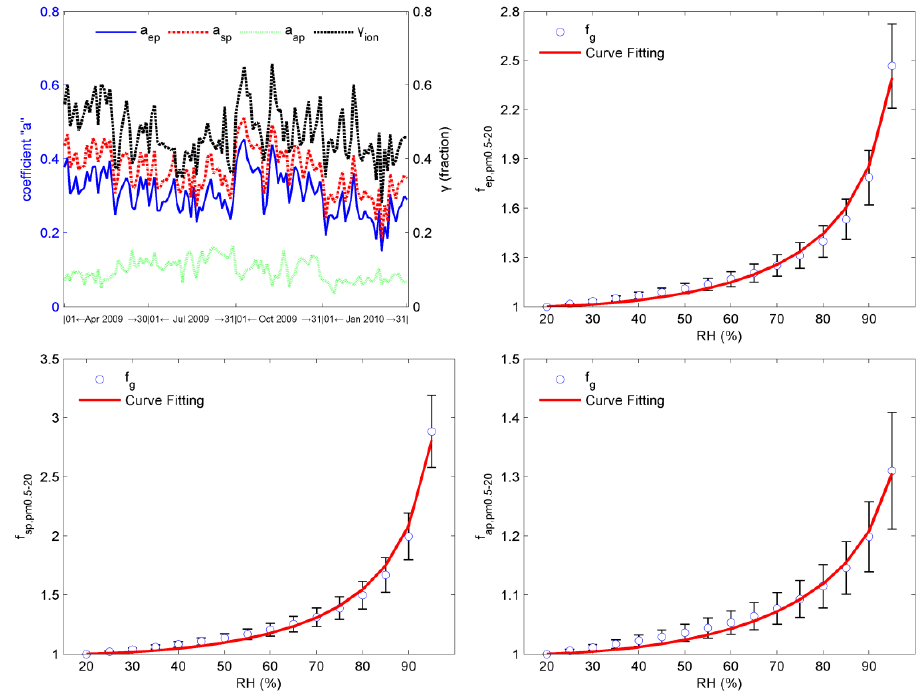
Figure 7 Temporal variations of coefficient “a” and RH dependence 468 Fig. 7. Temporal variations of coefficient “ a ” and the RH dependence curves of optical properties of PM 0 . 5 − 20 . Table 5. Ambient RH condition and the corresponding chemical composition of PM 2 . 5 .